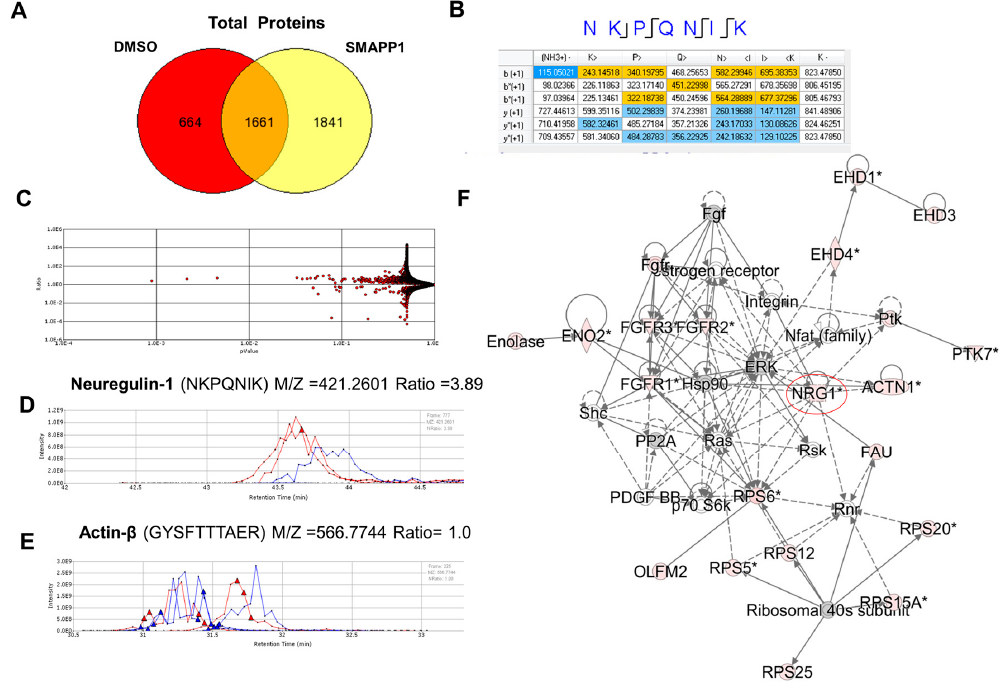
Figure 1. Small molecule activator of PP1 (SMAPP1) induces NRG-1 expression. ( A ) Venn diagram of proteins that were detected in CEM T cells treated with 10 µ M SMAPP1 or DMSO as control. Cellular proteins were extracted, reduced, alkylated and trypsinized. Tryptic peptides were separated by ion exchange chromatography and analyzed by high resolution mass spectrometry. Proteins were identified by Proteome Discoverer 1.2. Peptides eluted in 50 mM NaCl are shown on the diagram; ( B ) Tandem mass spectrometry (MS/MS) analysis of NRG-1 derived peptide in Proteome Discoverer 1.2. Blue color indicates high confidence and yellow —low confidence ions; ( C ) Peptides detected in the 50 mM salt fraction were quantified using SIEVE 2.1. The volcano plot shows ratios of peptides present in the 50 mM salt fraction in SMAPP1 versus DMSO treated samples with corresponding p -values; ( D , E ) Quantitative analysis of NRG-1 and β -actin expression using SIEVE 2.1. Ion elution profiles are shown in blue for control samples and in red for the CEM T cells treated with SMAPP1. Panel D shows the elution of the NRG-1-derived ion. Panel E shows the elution of the actin- β -derived ion. Results from two independent experiments are shown. Triangles indicate the time points at which MS/MS was conducted. Integration of the peaks was performed by SIEVE 2.1 and the ratios of the ion peaks in SMAPP1 versus control cells are shown, ( F ) Peptides detected in the 50 mM salt fraction and analyzed by SIEVE 2.1 were exported to Ingenuity software for the analysis of protein networks. A network with NRG-1 is shown. Up-regulated genes are colored in